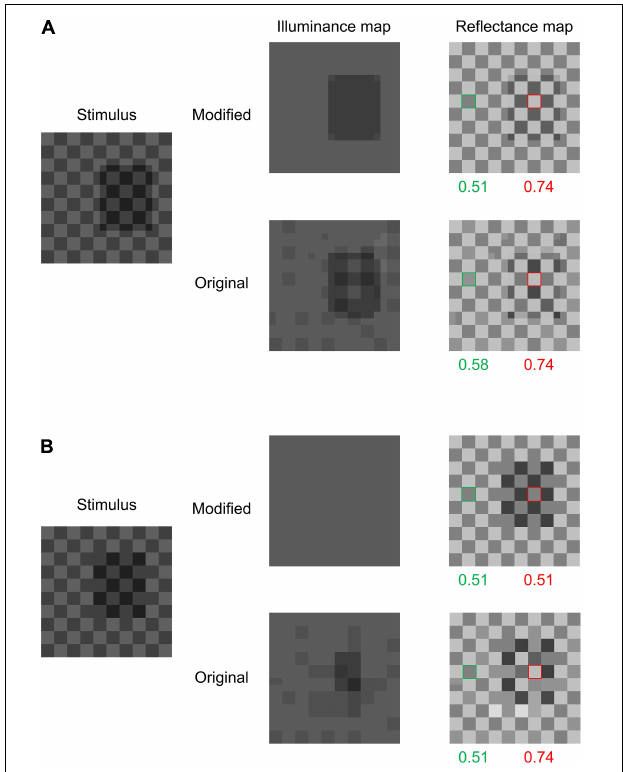
FIGURE 5 | (A) Simplified Ceckershadow Illusion (SCS) and both model outputs. Both models perceive the difference between the two target area reflectances (tiles with green and red frames), but the modified model perceives the shadowed region more clearly. (B) The SCS control and the models’ outputs for it. The modified model does not observe a reflectance difference, while the original model does.